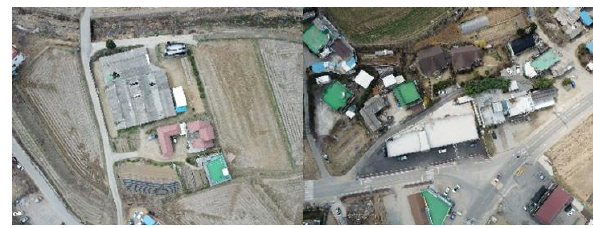
Figure 4. Examples of dataset B (reference images) Using the image dataset B, we performed structure from motion (SfM) and multi-view geometry (MVG) using Agisoft Metashape. The root means square error (RMSE) of ground control points was 9 cm. The generated dense point cloud and positions of the ground control points are shown in figure 5.